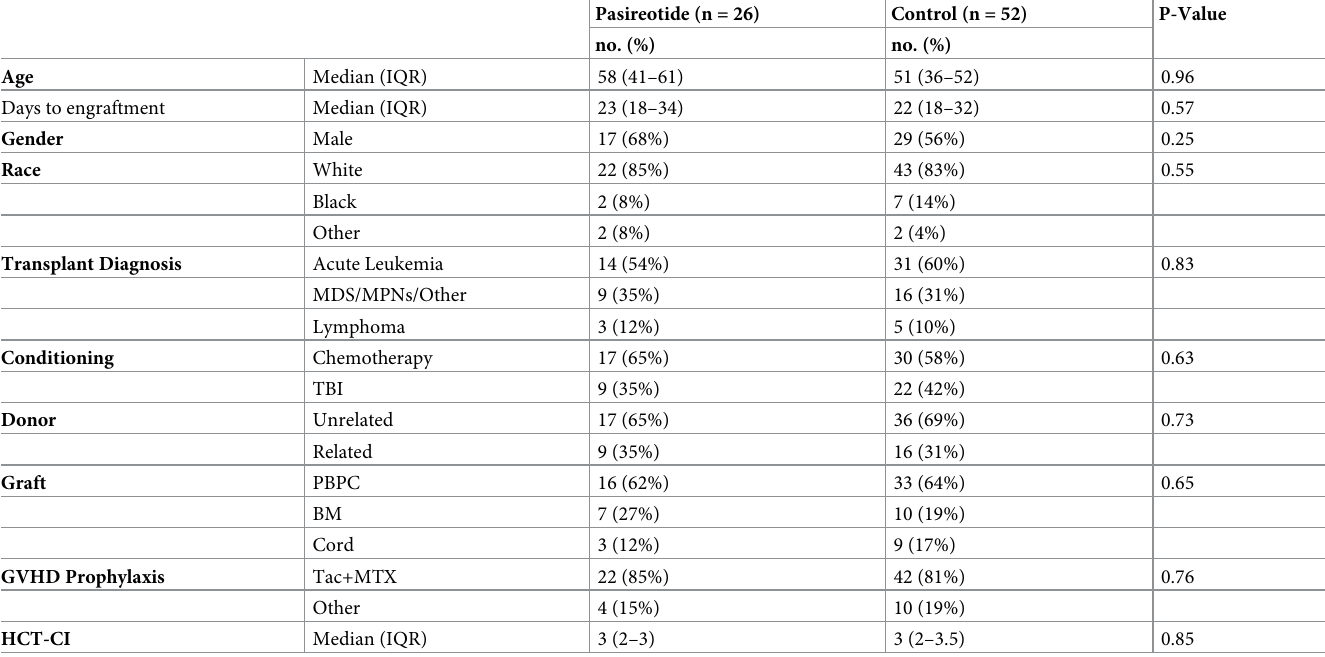
Table 1. Demographics of pasireotide and control